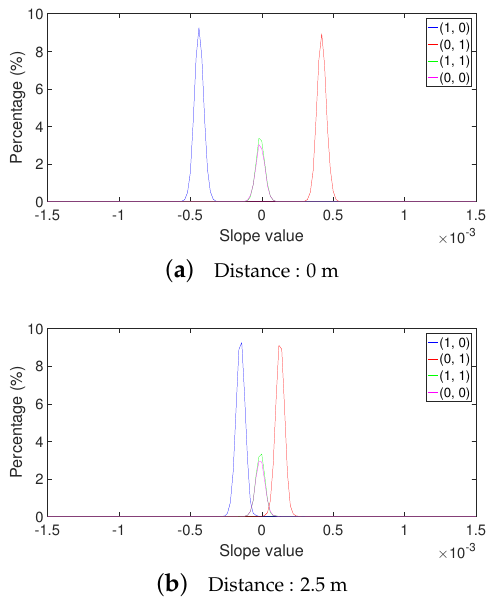
Figure 11. Distribution of slope values for different bit pairs at a bit rate of 100 kbps.